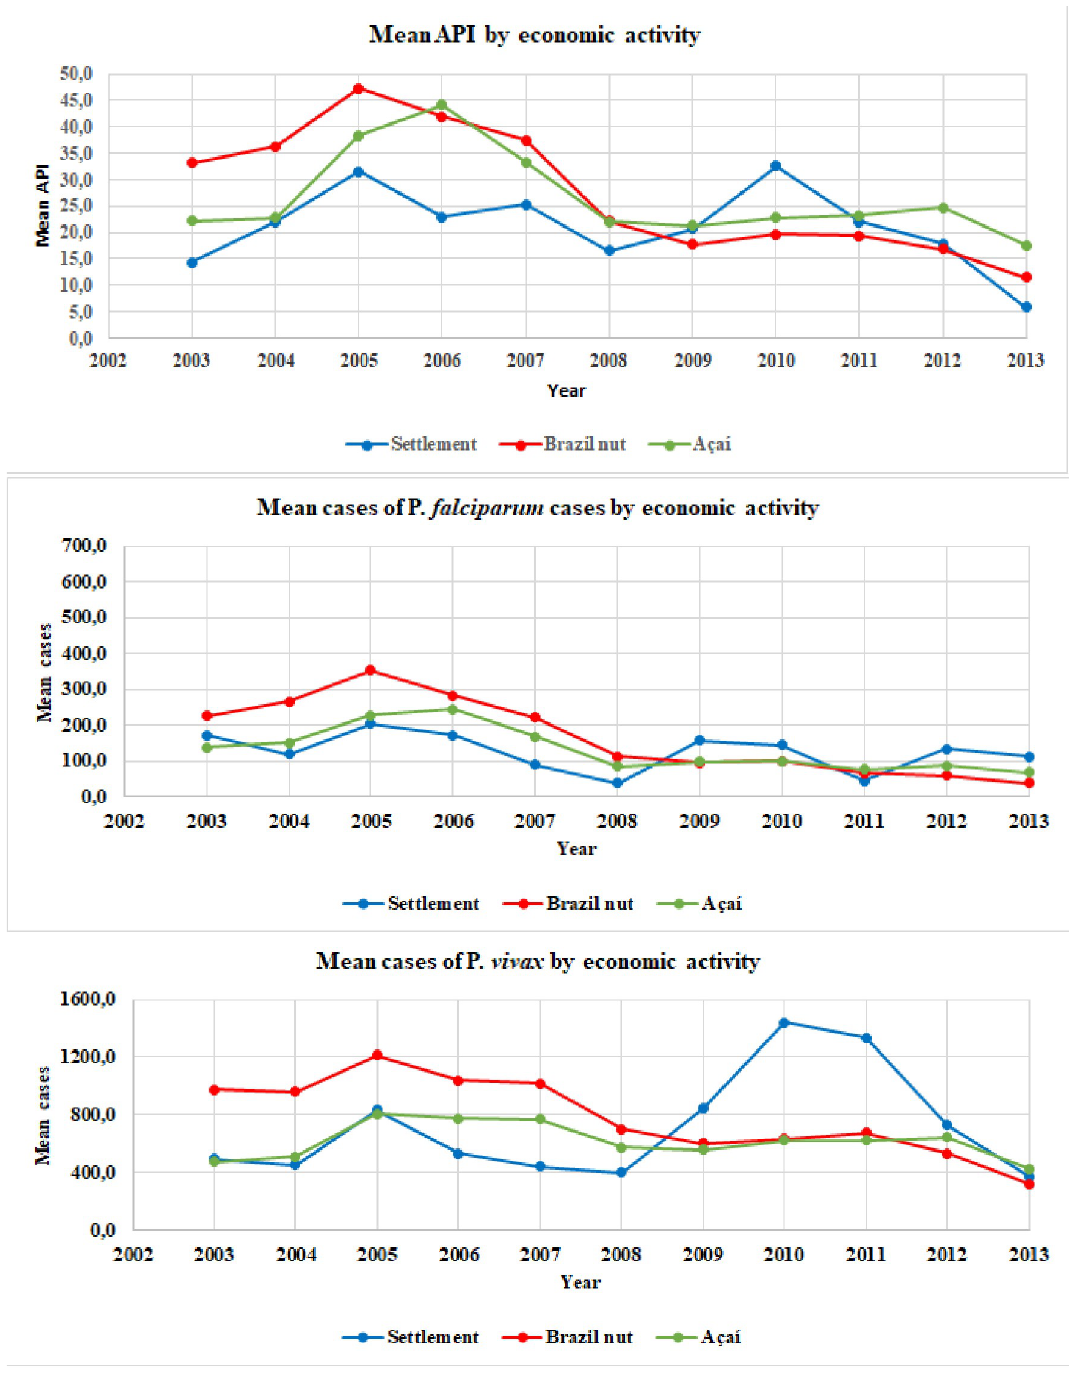
Fig 6. Mean API values of P . falciparum , and P . vivax by year of diagnosis and economic activity. Brazilian Amazon, 2003, 2005, 2010, and 2013.